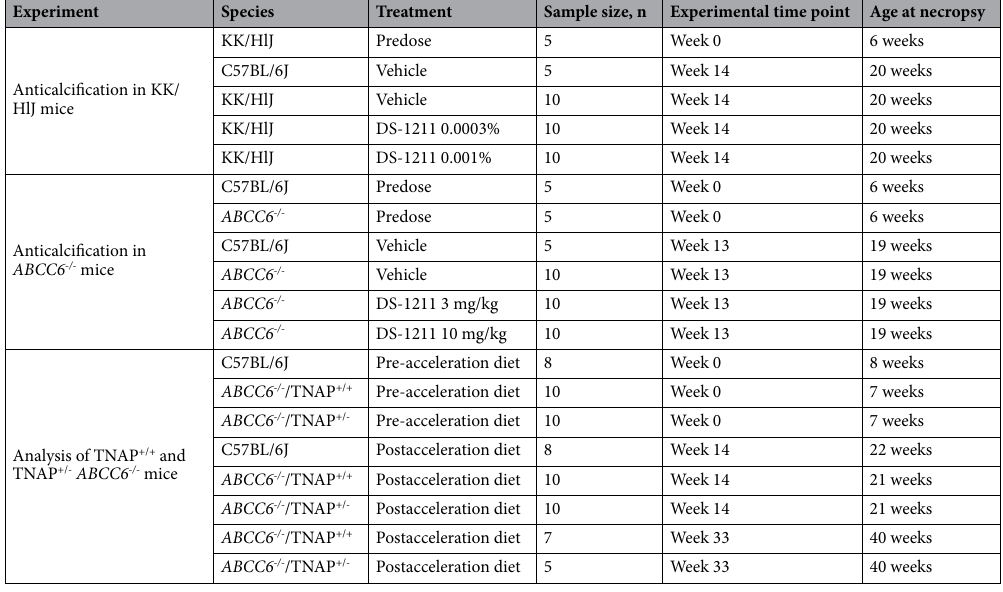
Table 1. Treatment groups in the mouse model experiments. TNAP tissue-nonspecific alkaline